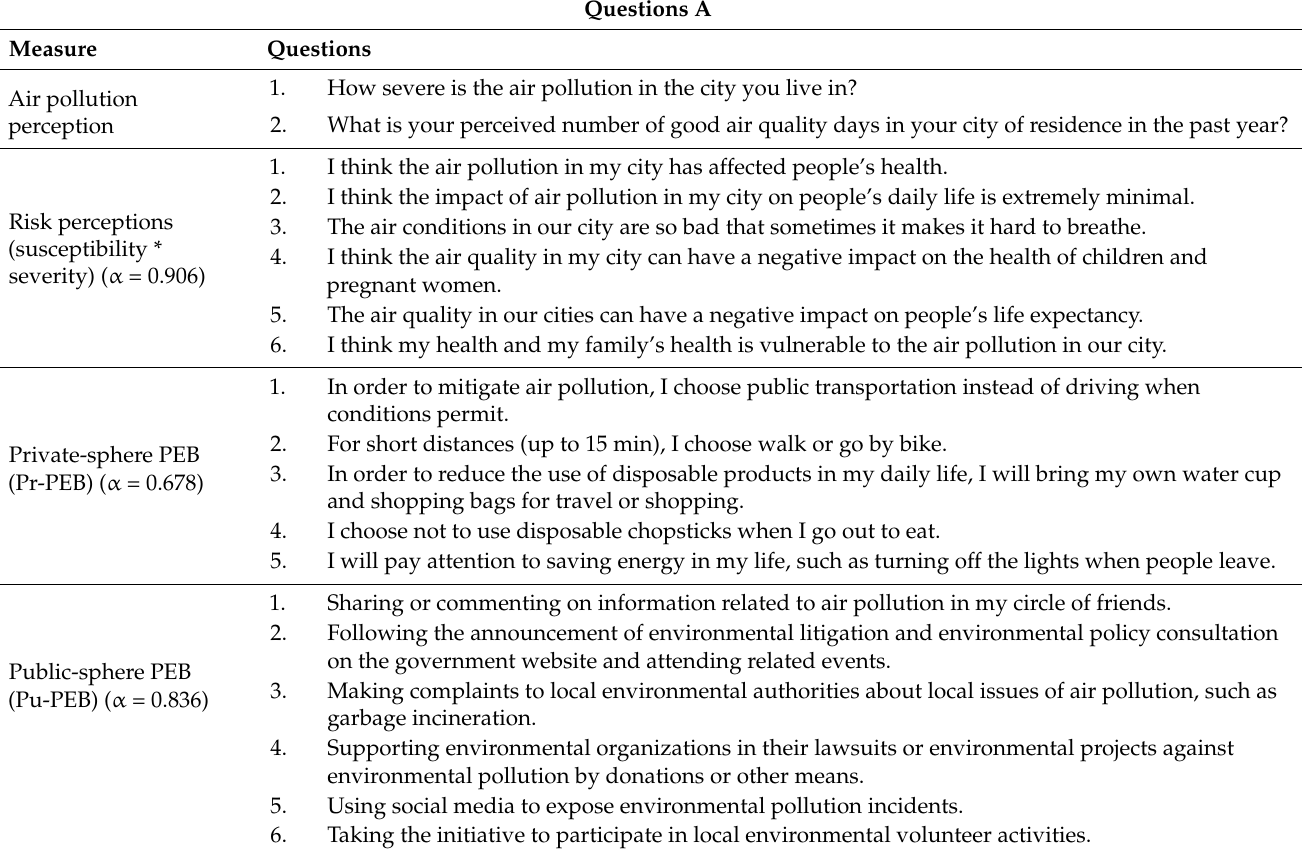
Table A4. Questionnaire